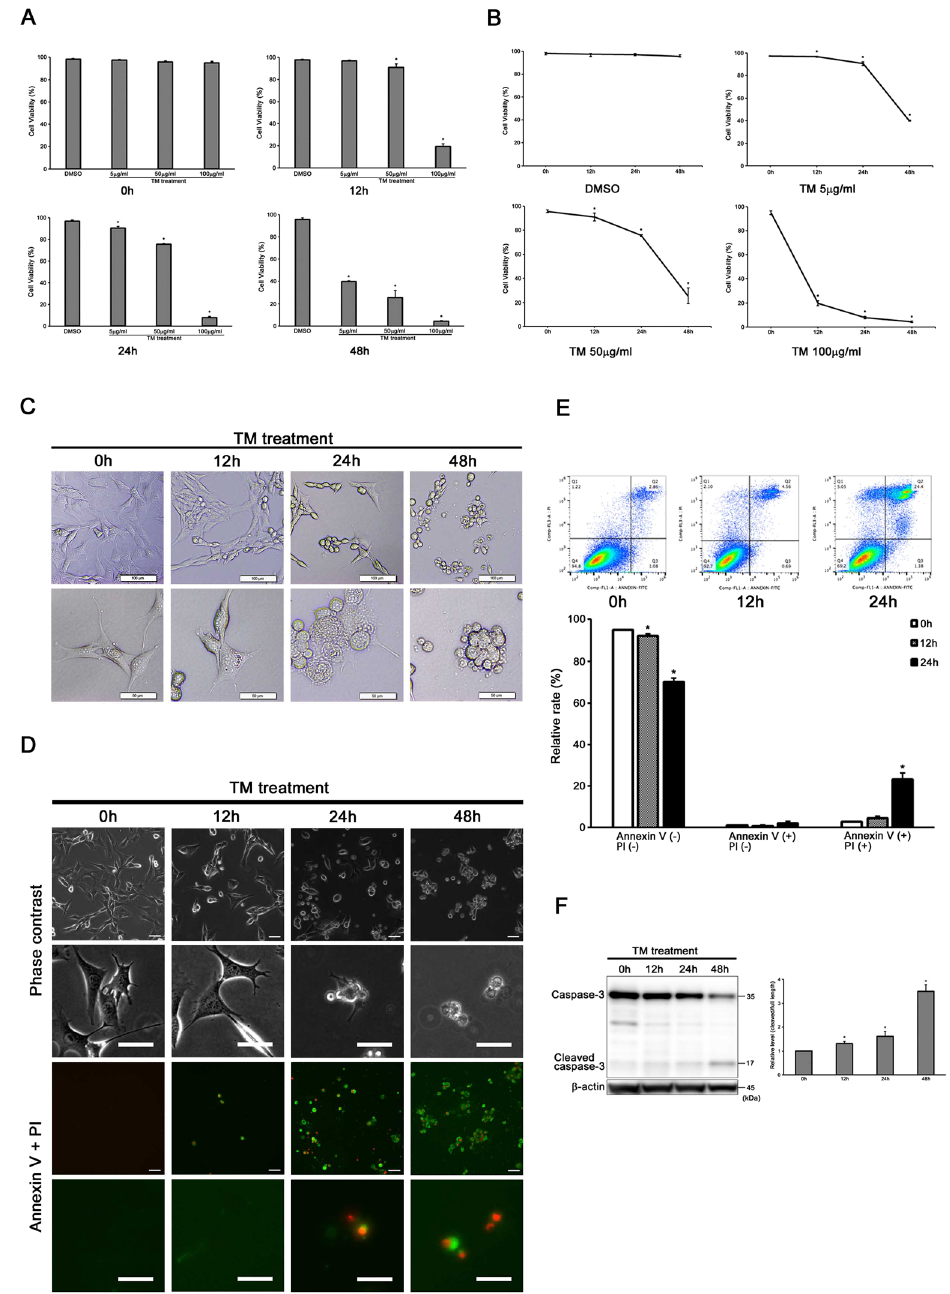
Figure 1. Tunicamycin treatment induces both apoptotic and necrotic cell death in auditory cells. ( A ) Cell viability was decreased in a dose-dependent manner in tunicamycin-treated HEI-OC1 cells. Cells were treated with different concentrations of tunicamycin (5, 50 and 100 µ g/ml) for 12, 24 and 48 h. ( B ) Cell viability was decreased in time- dependent manner in tunicamycin-treated HEI-OC1 cells. ( C ) Cells were treated with 50 µ g/ml tunicamycin for designed periods of time (12, 24 and 48 h). Cells morphology was observed under light microscopy. The structure of nucleus was normal in the cells with sharp cell process (50 µ g/ml for 0 and 12 h). Cell membrane was swollen, and nucleus was enlarged in tunicamycin-treated HEI-OC1 cells (50 µ g/ml for 24 h). The cell membrane breaks down with extraction cellular contents (50 µ g/ml for 48 h). ( D ) Representative fluorescence microscopy images of cells treated with tunicamycin (50 µ g/ml) for designed periods of time (12, 24 and 48 h) stained with Annexin V and PI. Scale bars, 50 µ m. ( E ) Flow cytometry showed the increased populations at late apoptosis and at necrosis (Annexin V + , PI + ). The data in ( A ), ( B ) and ( E ) are shown as means ± S.D. of three or more independent studies ( * p < 0.05 versus control group). ( F ) Representative Western blots showing the expressions of full length and cleaved caspase-3. β -actin was included as a loading control. The expressions of full length and cleaved caspase-3 was detected, and the means ± S.D. (fold of changes over the control group) of three or more independent studies were presented ( * p < 0.05 versus control group). Full-length blots are presented in Supplementary Figure 1a and